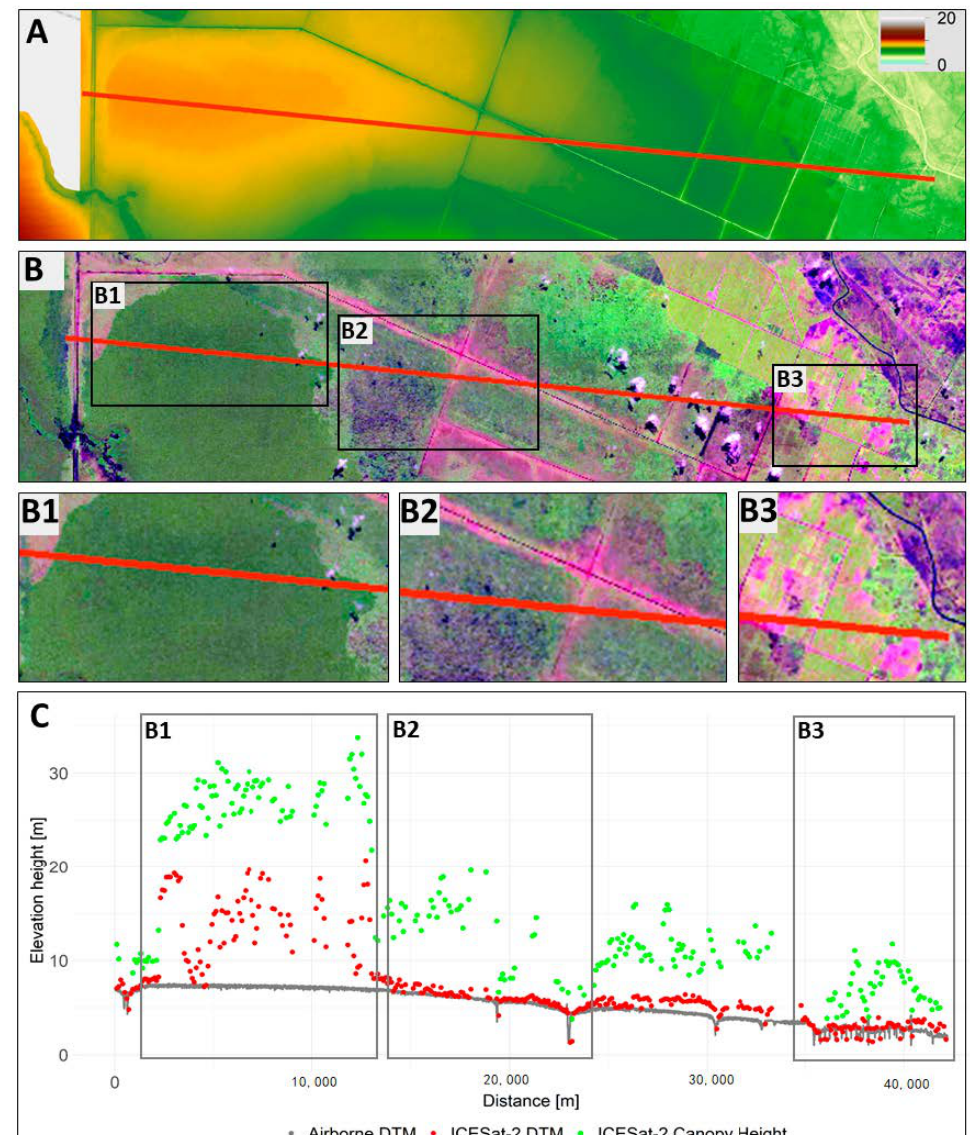
Figure 4. The disturbance of the ICESat-2 DTM by different land covers as detected along a 42 km north–south transect. The transect covers dense and tall peat swamp forests, previously burned forests, and a recently planted oil palm plantation. ( A ) Airborne LiDAR DTM—the peat dome descends from north to south by approximately 8 m. Green colors indicate low-lying terrain while brown indicates higher elevations. ( B ) Sentinel-2 satellite image acquired in October 2019 (bands SWIR, NIR, Red) showing forest areas in green, burned areas in pink, and oil palms in bright green. ( B1 – B3 ) Enlarged areas indicated by black rectangles in B. ( B1 ) Tall peat swamp forest. ( B2 ) Burned forest with regrown shrubs and trees. ( B3 ) Plantation. ( C ) Height profile of the airborne DTM (gray) and the ICESat-2 DTM measurements (red dots). Green dots show the canopy height as measured by ICESat-2. Bounding boxes B1, B2, and B3 represent the height profiles of the specific areas within B.